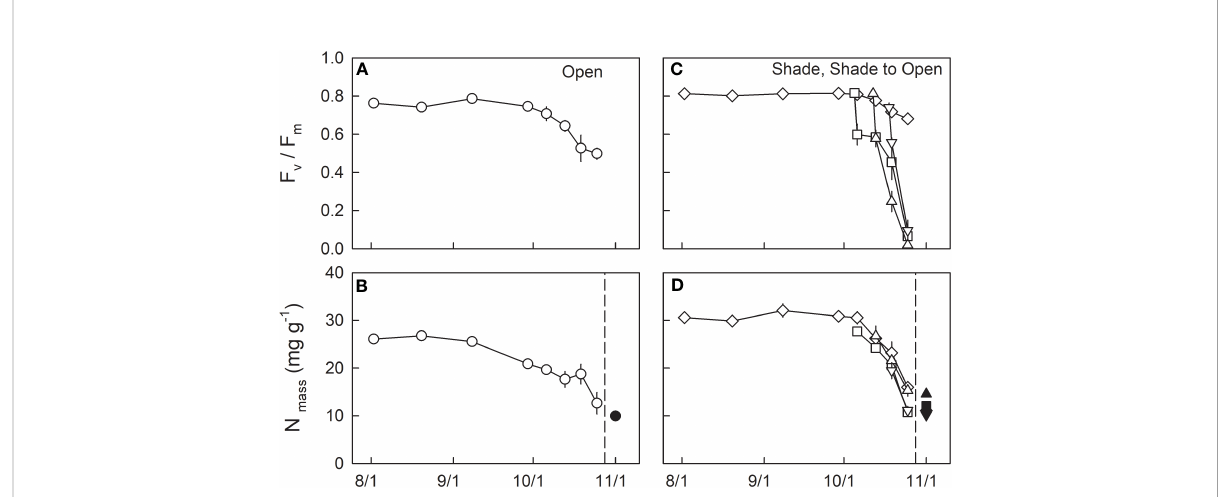
FIGURE 3 Seasonal changes in F v /F m (A, C) and dry mass-based leaf N (B, D) in leaves of fullmoon maple grown under open (H0: circle), shade (L0: diamond), and shade to open (LH1: square, LH2: triangle up, and LH3: triangle down) conditions. Seedlings grown under shade were transferred to open conditions on 5 th (LH1: square), 12 th (LH2: triangle up), and 18 th (LH3: triangle down) of October. Open symbols indicate attached leaves (n = 3 to 6), whereas closed symbols indicate pooled data for shed leaves collected from 25 October to 1 November (n = 9 to 22). Values are means ± se. Detailed results of statistical analyses are shown in Tables 1, 2.